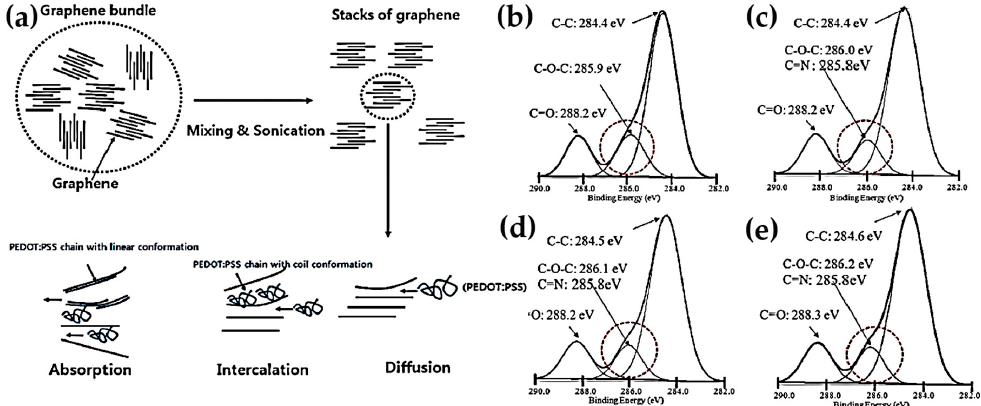
Figure 4. ( a ) The mechanism of dispersion of aggregated graphene in the polymer (PEDOT:PSS) during mixing and sonication processing. C1s x ‐ ray photoelectron spectroscopy (XPS) peaks of ( b ) PEDOT:PSS, ( c ) PEDOT:PSS containing 1 wt% graphene, ( d ) PEDOT:PSS containing 2 wt% graphene, and ( e ) PEDOT:PSS containing 3 wt% graphene. Reprinted with permission from [106]. Copyright 2012 The Royal Society of